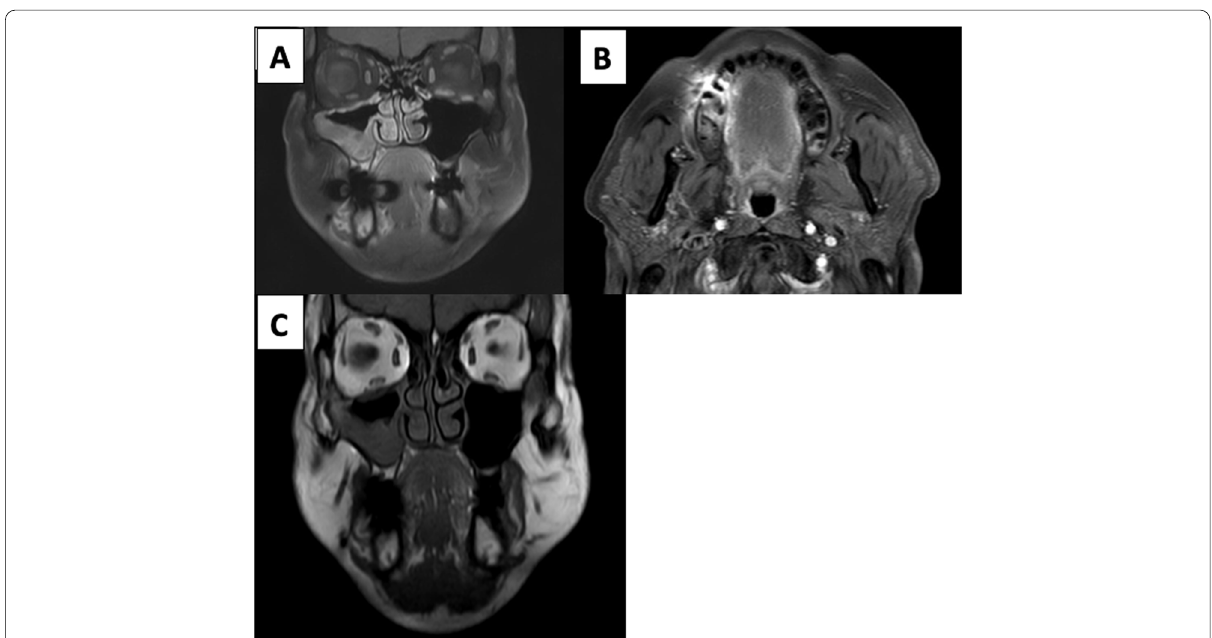
Fig. 3 A , B Coronal and axial T1 fat-sat post-contrast images show right maxillary sinusitis and artefacts from dental fillings causing hyperintensities in right half of alveolar processes of maxilla and mandible, buccal, and lingual aspects of oral cavity. C Non-fat-sat coronal T1 image shows preserved normal fatty marrow signal of maxillary and alveolar processes on the right